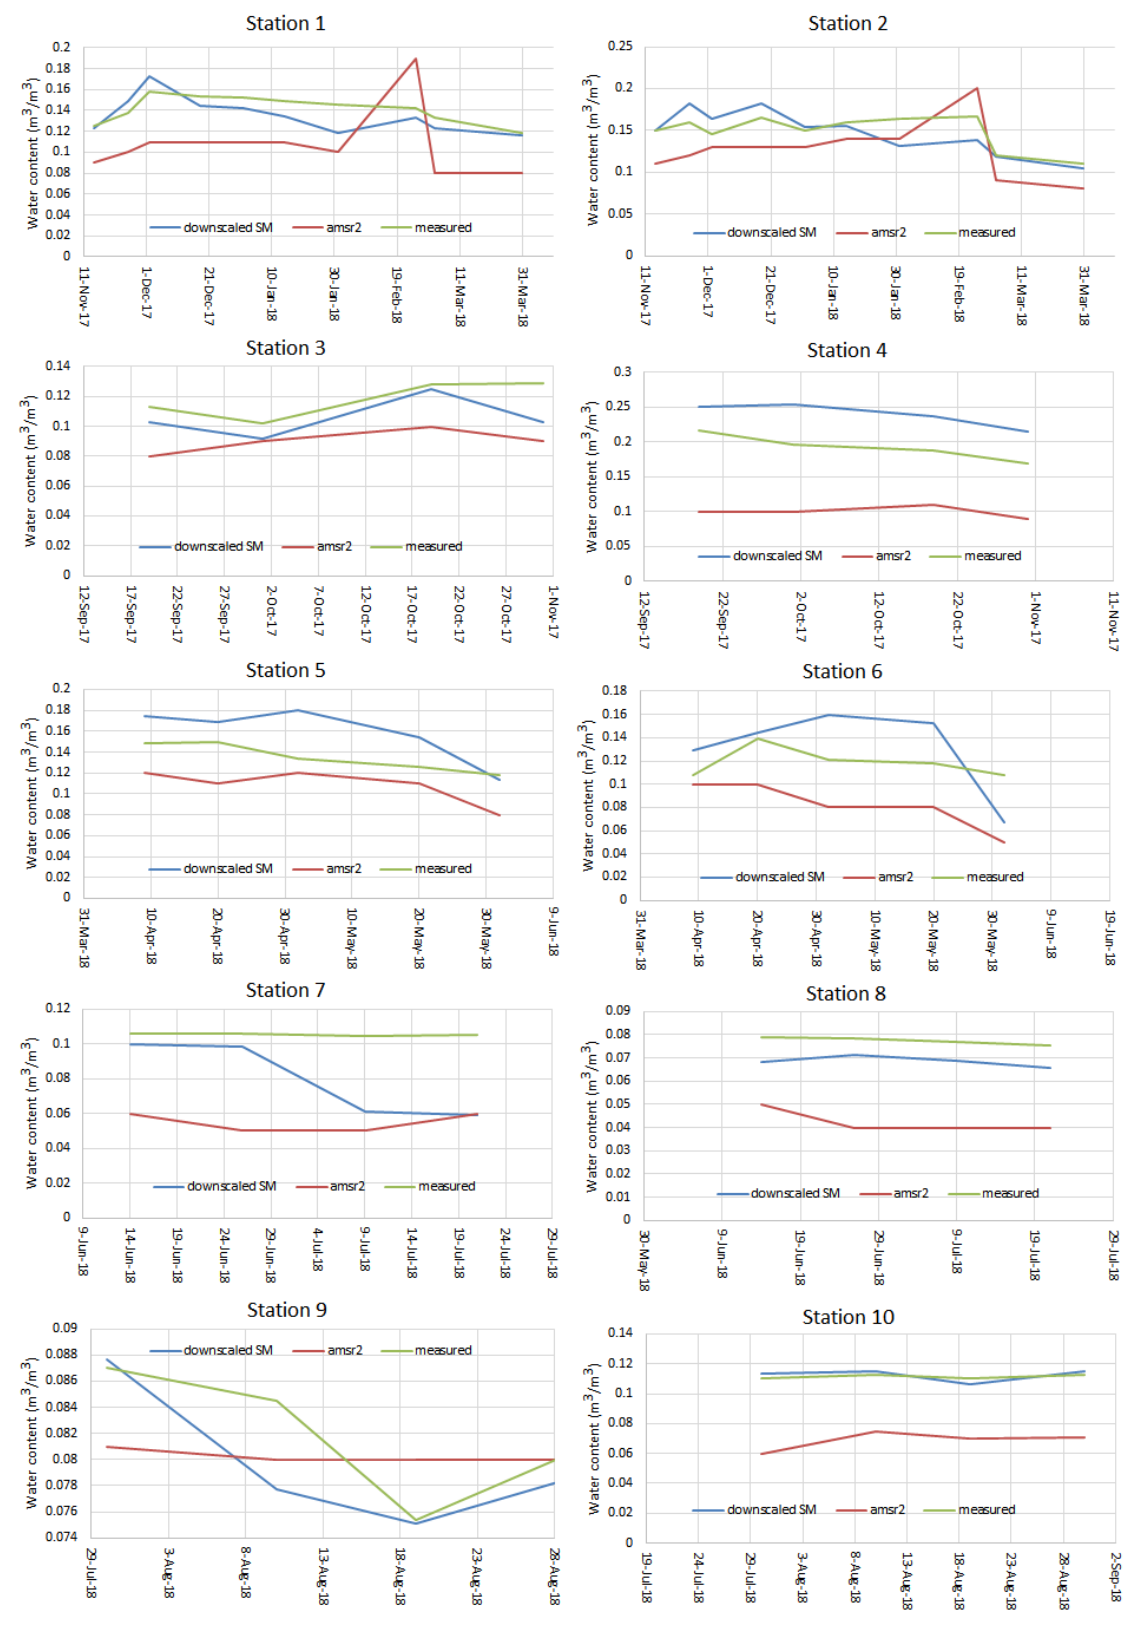
Figure 6. Time series of Measured, ordinary AMSR2, and downscaled ASMR2 SSM data at ten study stations. Stations 1–10 correspond to the numbered red dots in figure 1a.